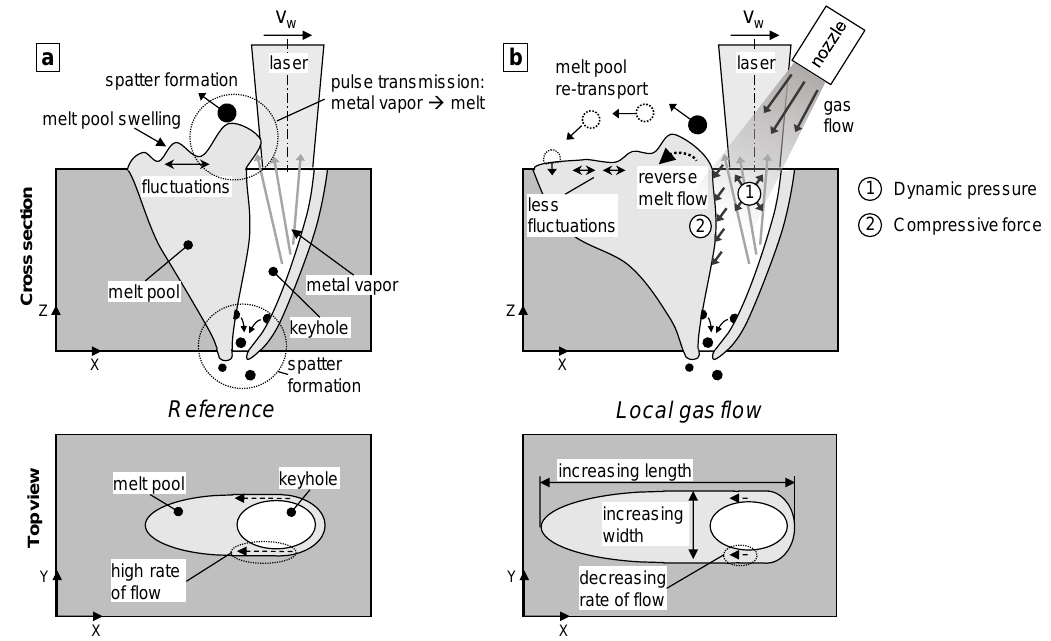
Figure 11. Schematic illustration of the effect mechanism: ( a ) Reference process; ( b ) Local gas flow.